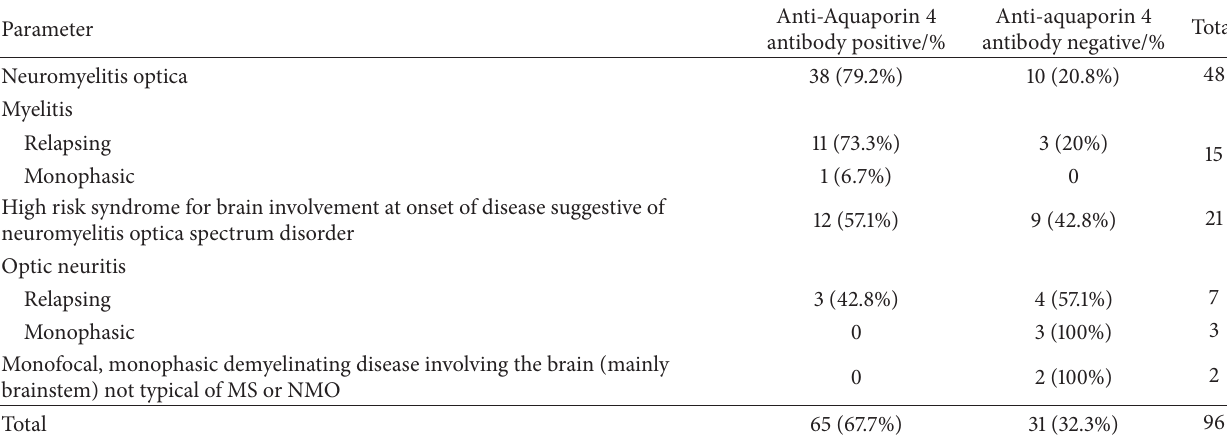
Table 2: Frequency of anti-AQP4 antibody in patients with neuromyelitis optica and high risk syndromes for neuromyelitis optica. Parameter